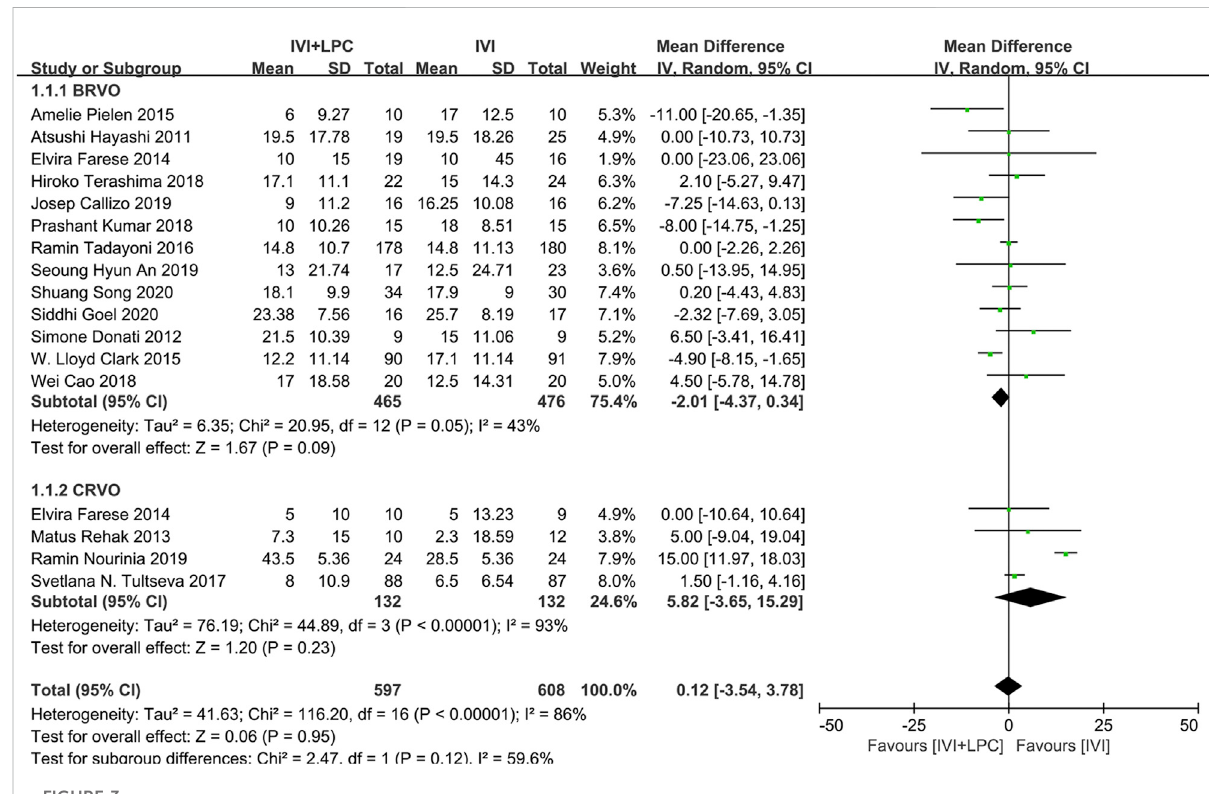
FIGURE 3 Comparison of BCVA between combination(IVI + LPC) treatment group and single IVI treatment group.